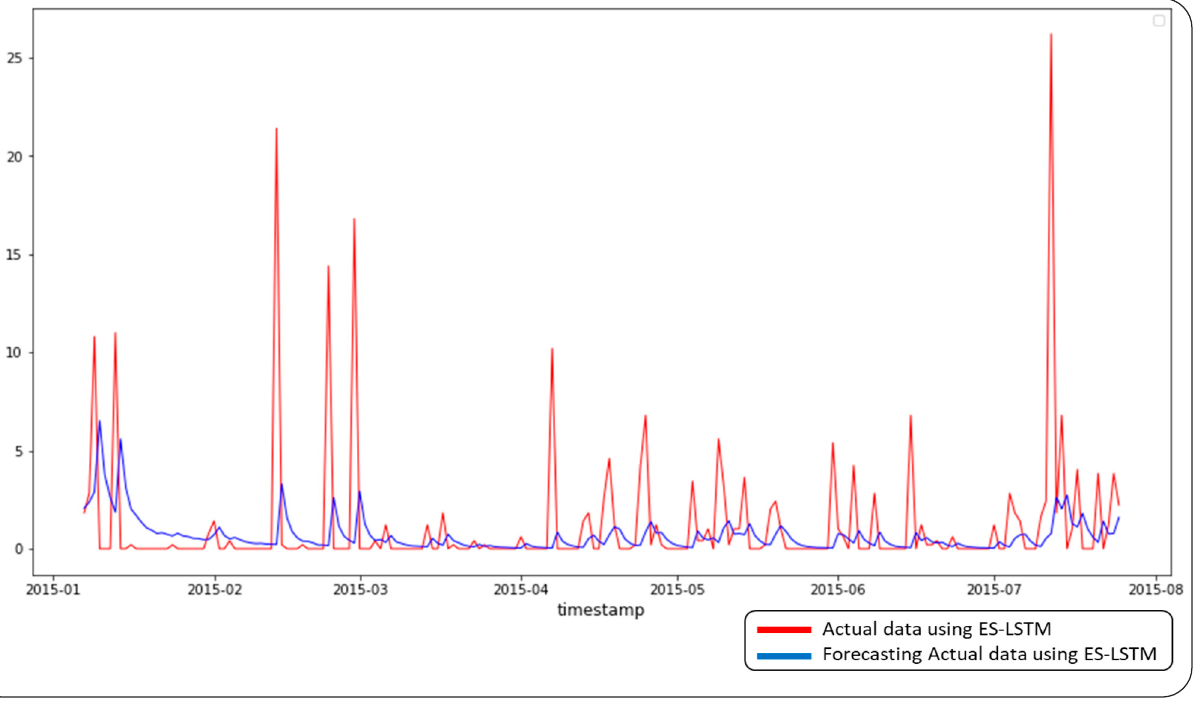
Table 6. Results of ANN and DT